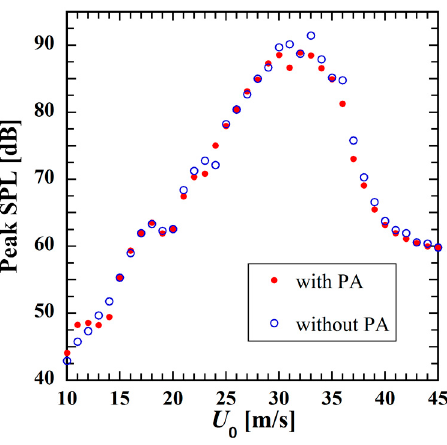
Figure 6. Comparison of the sound-pressure level SPL of the cavity flow both with and without a flush-mounted actuator.